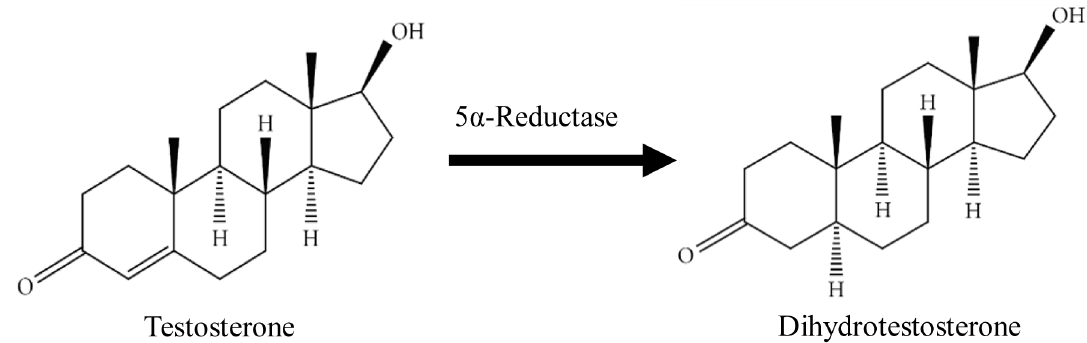
Figure 1. The conversion of dihydrotestosterone from testosterone by 5-alpha-Reductase. The figure is adapted and modified from National Center for Biotechnology Information